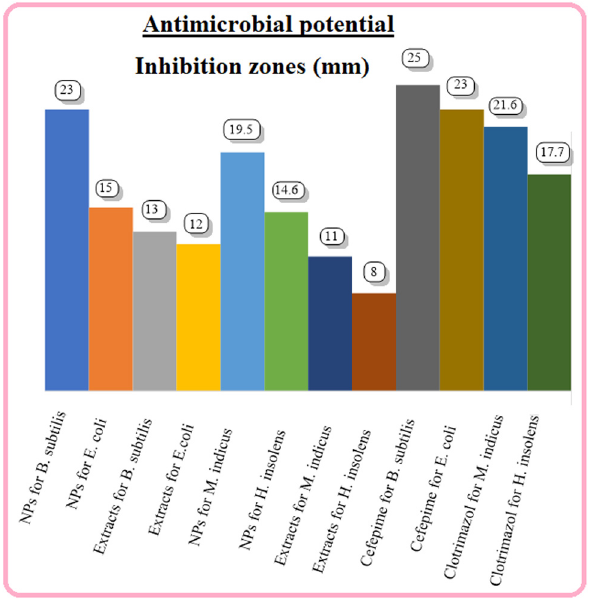
Figure 5: Antimicrobial activity of biogenic ZnO NP, extracts, and positive controls for bacterial and fungal